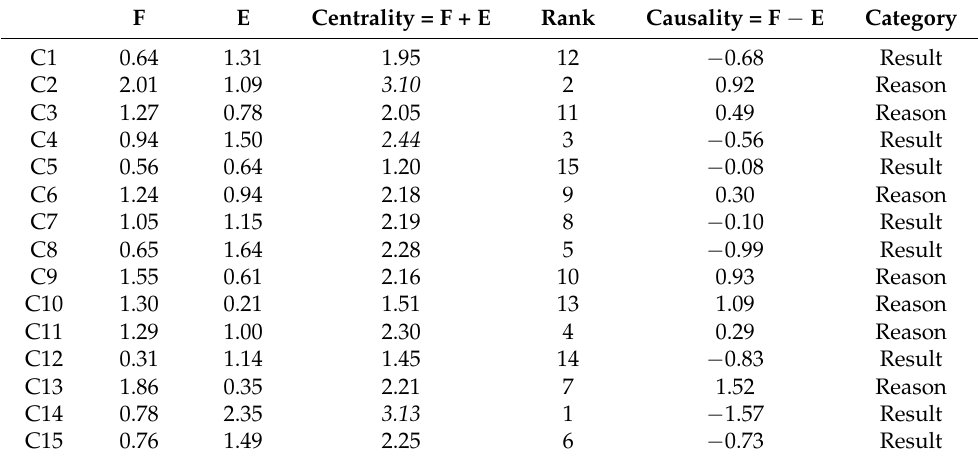
Table 7. The degree of centrality and causality.